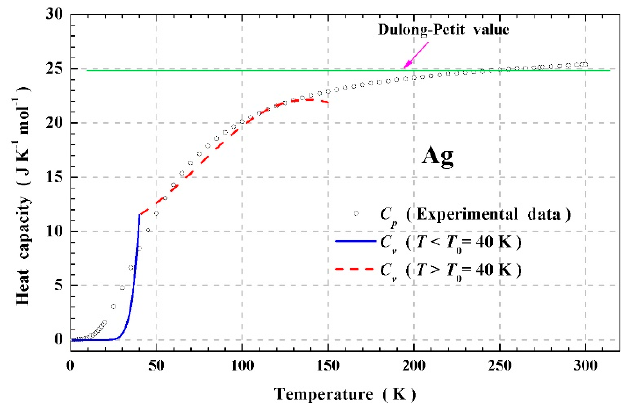
Figure 1. The experimental molar heat capacity at constant pressure, C p , [18–20] of bulk silver crystal Figure1. Theexperimentalmolarheatcapacityatconstantpressure, C p ,[18–20]ofbulksilvercrystalfitswith thetheoreticalmolarheatcapacityatconstantvolume, C v